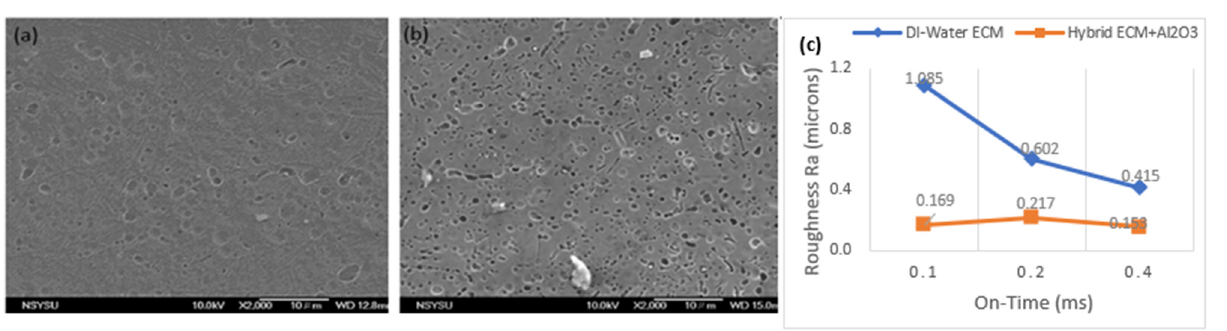
Table 4. Operation conditions for slot milling with deionized